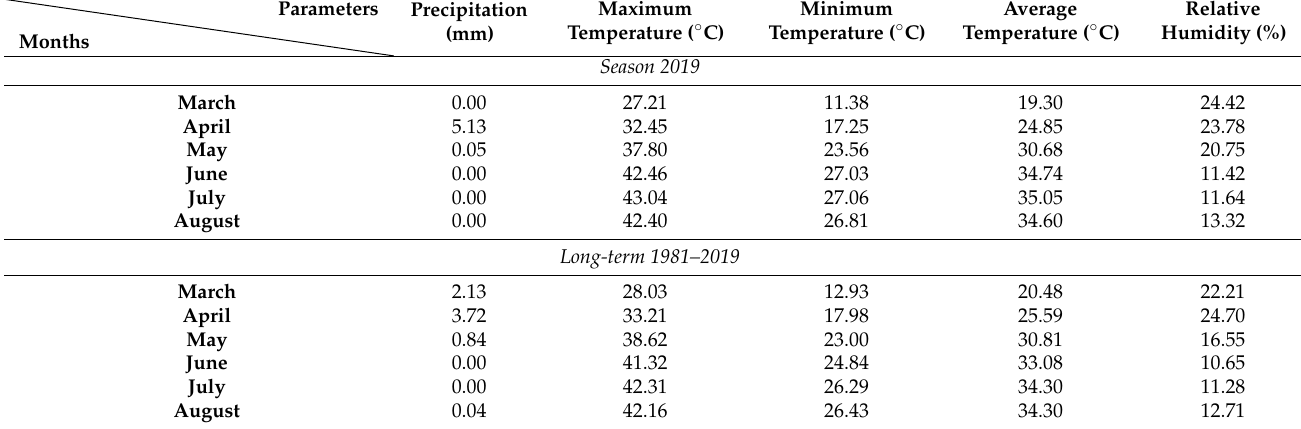
Table 3. Precipitation level and the average of temperatures and relative humidity during the period of the experiment.